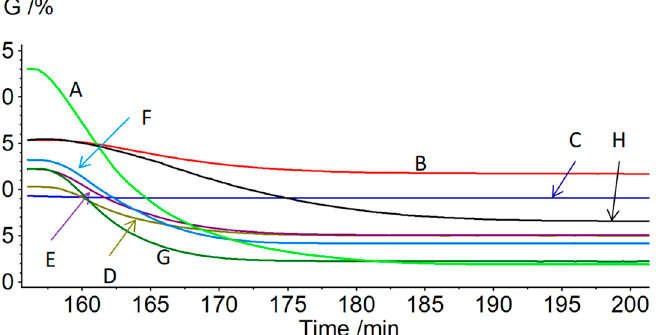
Figure 4. TGA data for lactose ( A ), SPR ( B ), Bakken ( C ), Monterey ( D ), Diatomite ( E ), Orcutt zones S2–S6 ( F ), Orcutt zone S1B ( G ), and Grassy Creek ( H ), during the 500 °C oxidation step under dry air after pyrolysis.